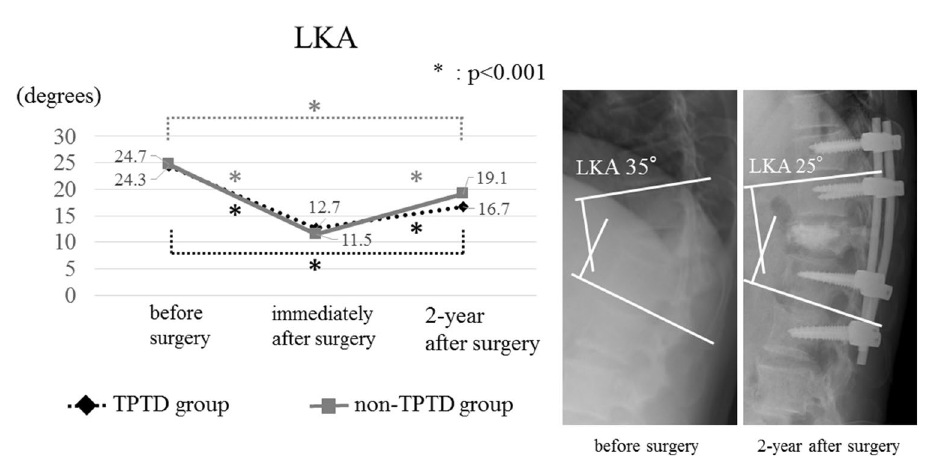
Figure 2. Mean local kyphosis angle (LKA) observed preoperatively, immediately after surgery, and 2 years after surgery; the figure depicts the changes in LKA and reveals that there was significant correction in both patient groups ( TPTD teriparatide).